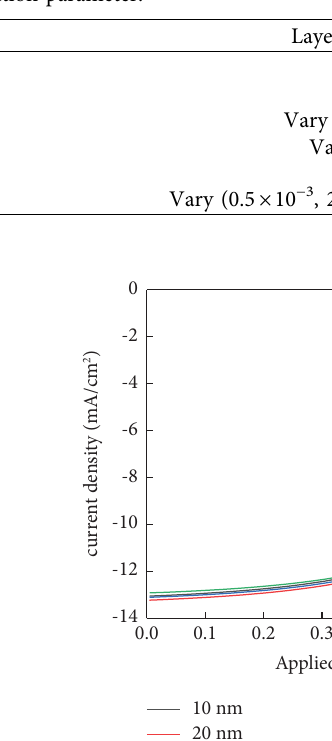
Table 1: Simulation parameter.